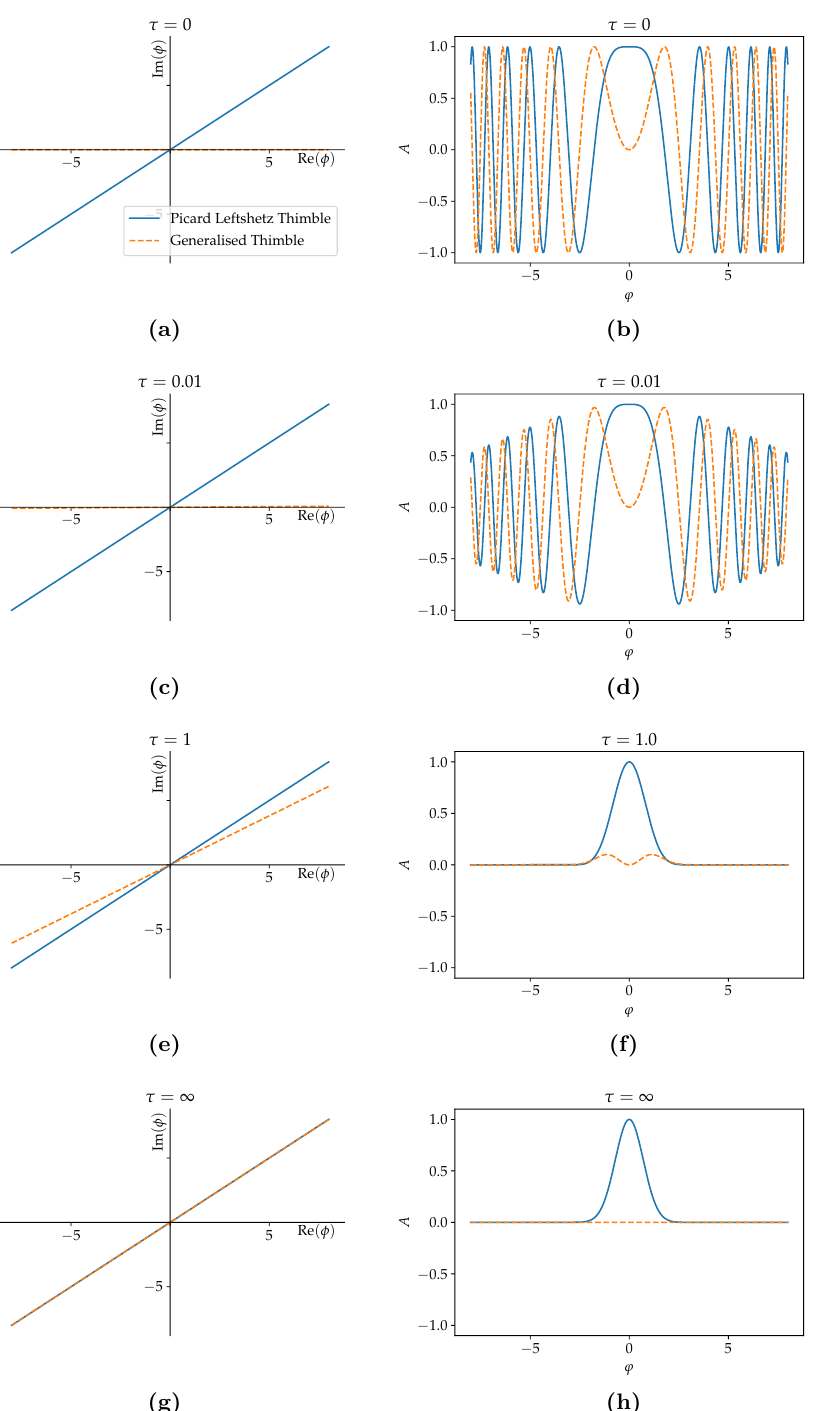
Figure 1. The thimbles (left) and the real and imaginary parts of the integrand along the general- ized thimble (right), A = exp[ −I ( φ )] , where I ( φ ) = − 1